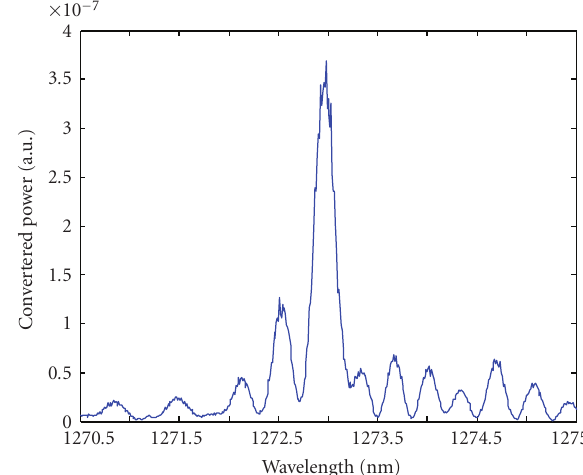
Figure 6: Measured transmission power against wavelength for Ti:PPLN ˇSolc-type wavelength filter with 16.7 μ m-period: center wavelength (1273 nm), FWHM bandwidth ( ∼ 0.23 nm).